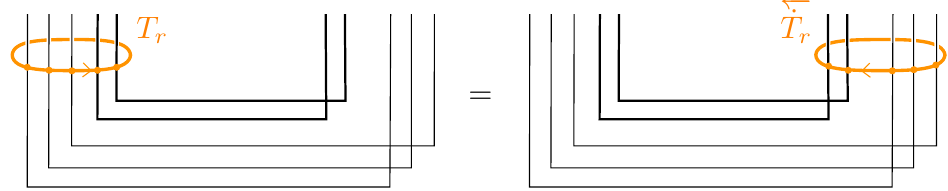
Figure 7. \Yangian" symmetry for three-point functions. The thin black lines denote the magnons in the (cid:12)rst hexagon ( (cid:11) ) whereas the thick bold lines denote the magnons in the second hexagon (cid:22) (cid:11) . Using the Yang-Baxter equation, one can move the transfer matrix from the left to the